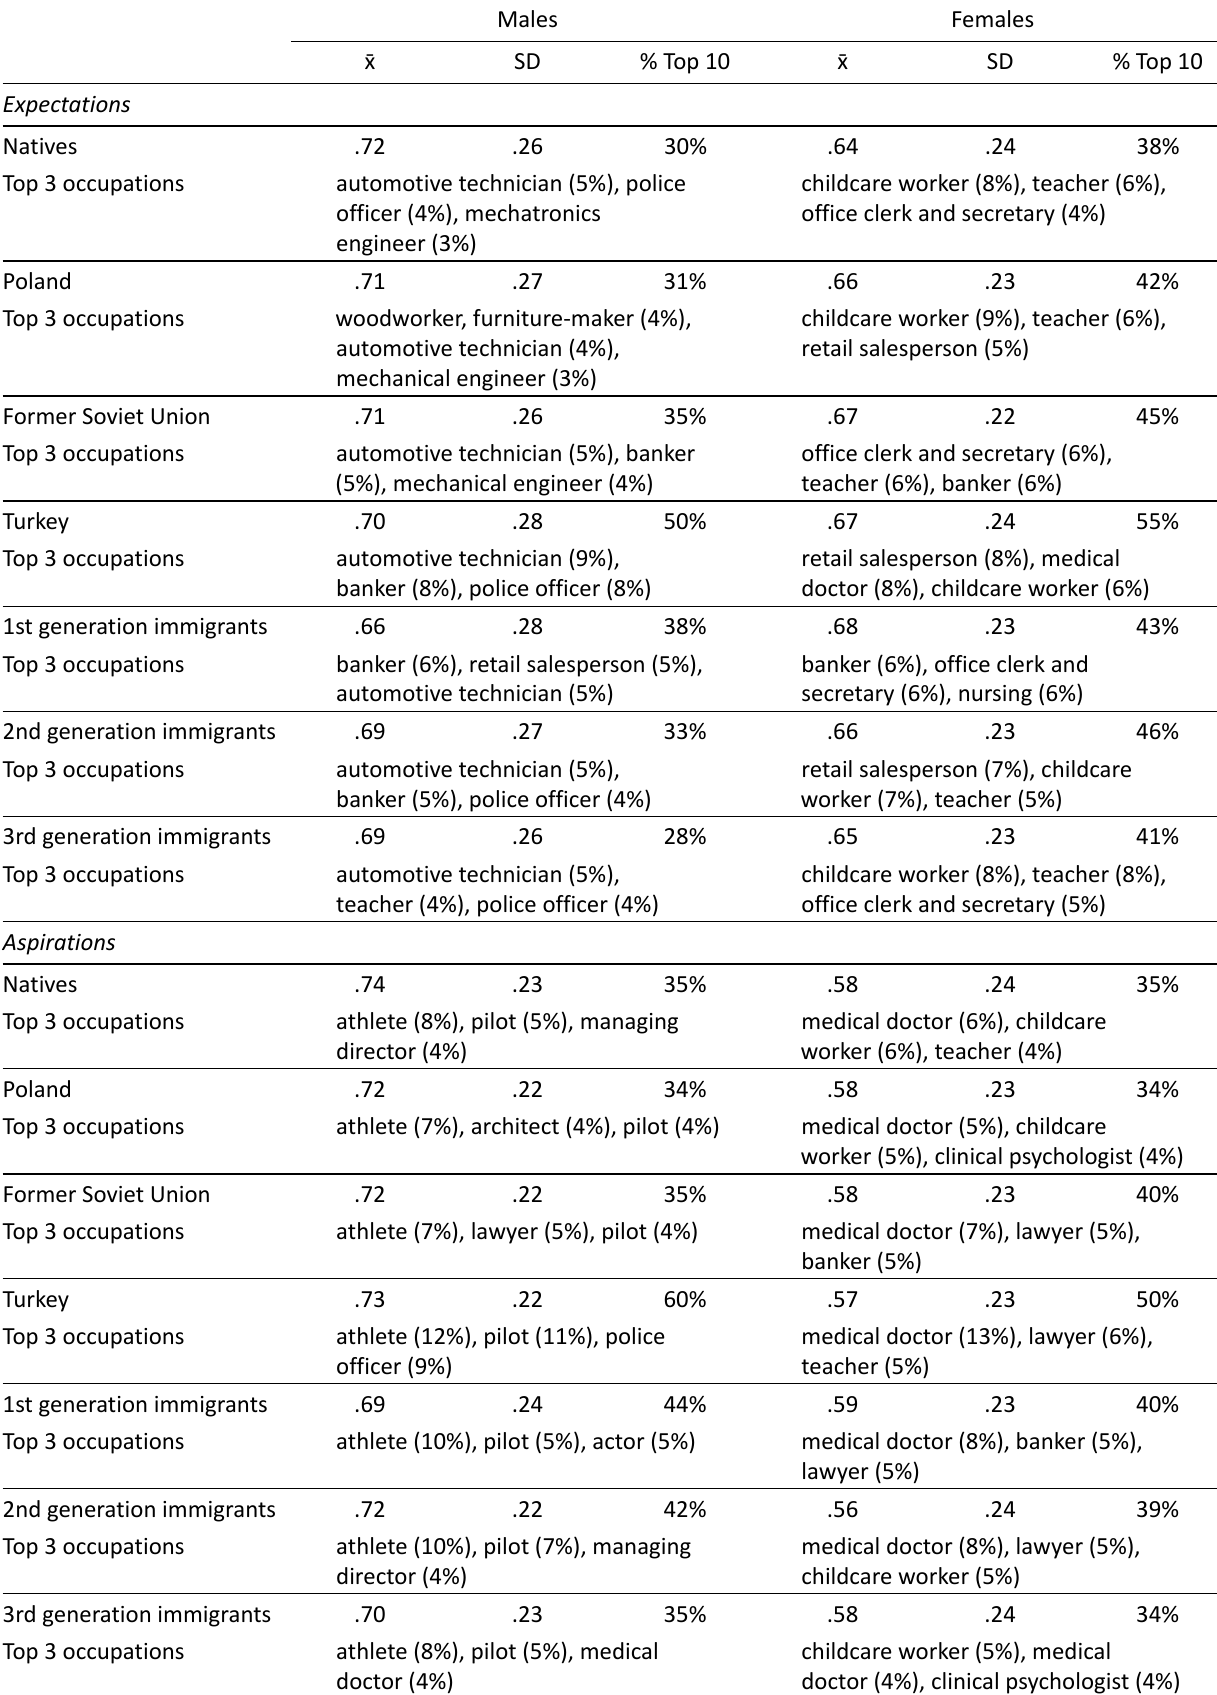
Table 3. Descriptive statistics of GTOO by ethnic origin and gender (non‐imputed